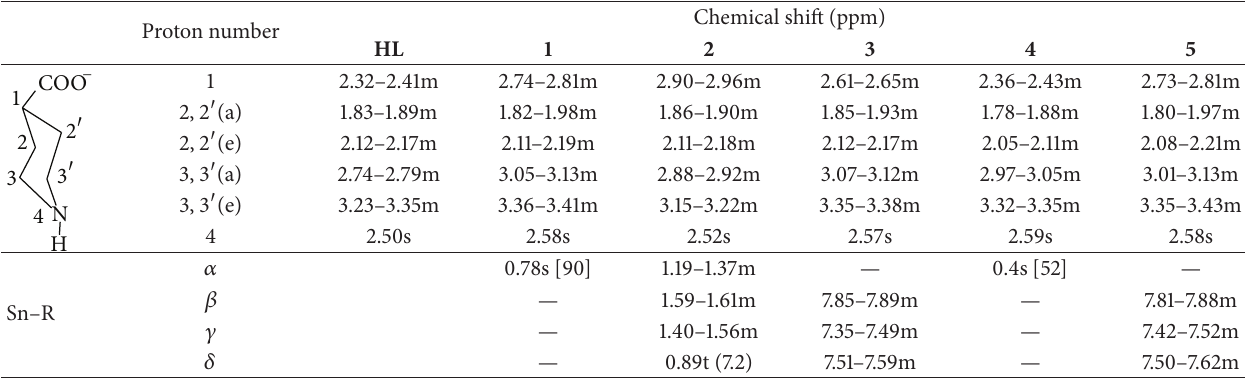
Table 3: 1 H NMR data a of organotin complexes 1–5 .